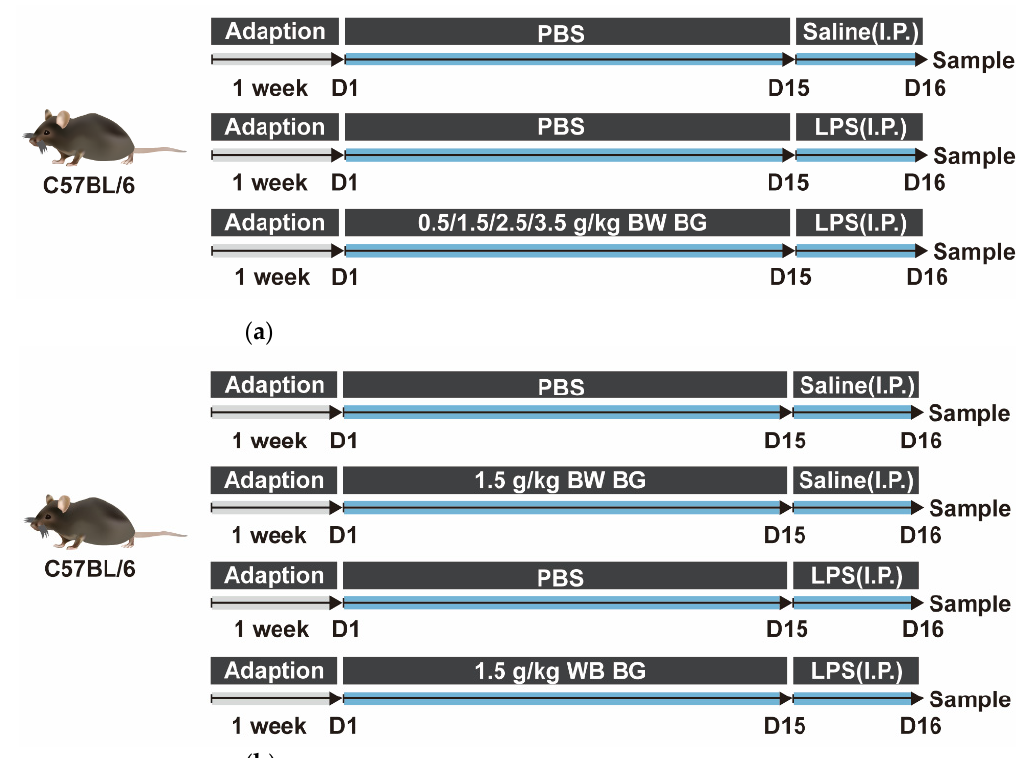
Figure 1. Schematic for the experimental design. ( a ) Dosage screening trial of BG for alleviating intestinal inflammation and barrier dysfunction in LPS-stimulated mice; ( b ) Effects of 1.5 g/kg BW BG on intestinal inflammation and barrier dysfunction in mice challenged by LPS.